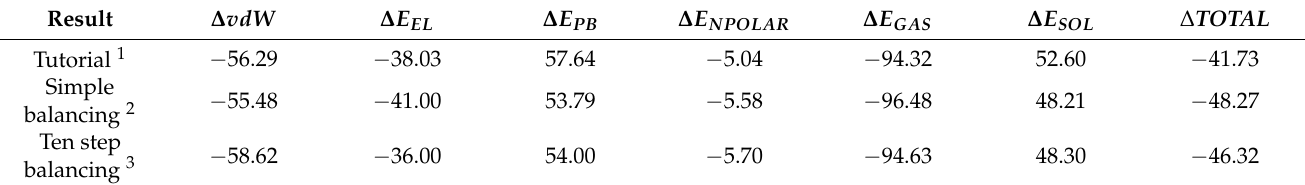
Table 2. Comparison of MM-PBSA and component results from 2 ns MD simulations of the raloxifen- estrogen receptor